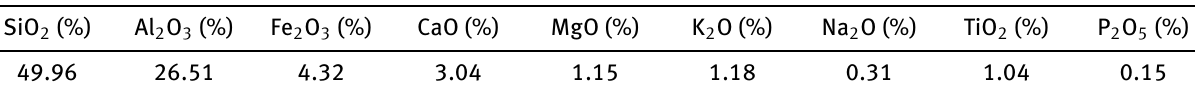
Table 4: Chemical composition of fly ash.